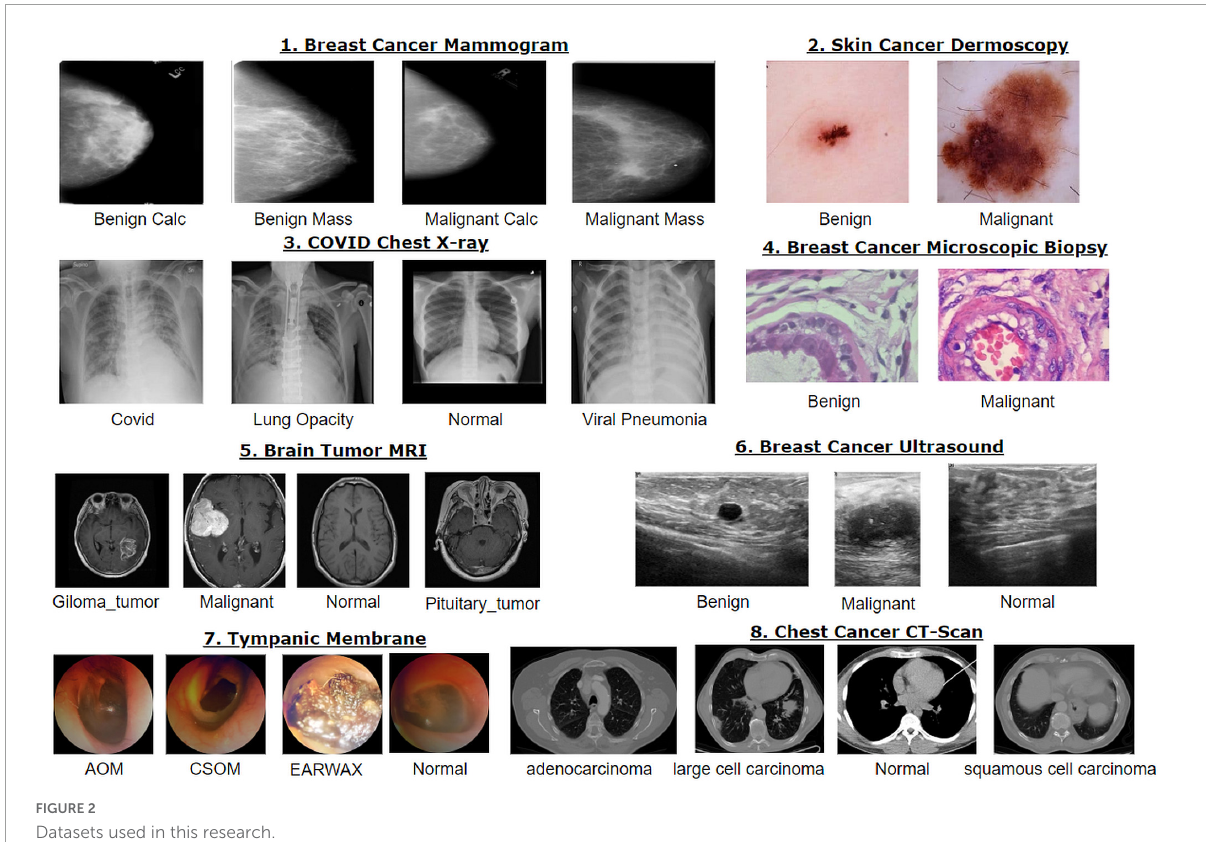
FIGURE2 Datasets used in this